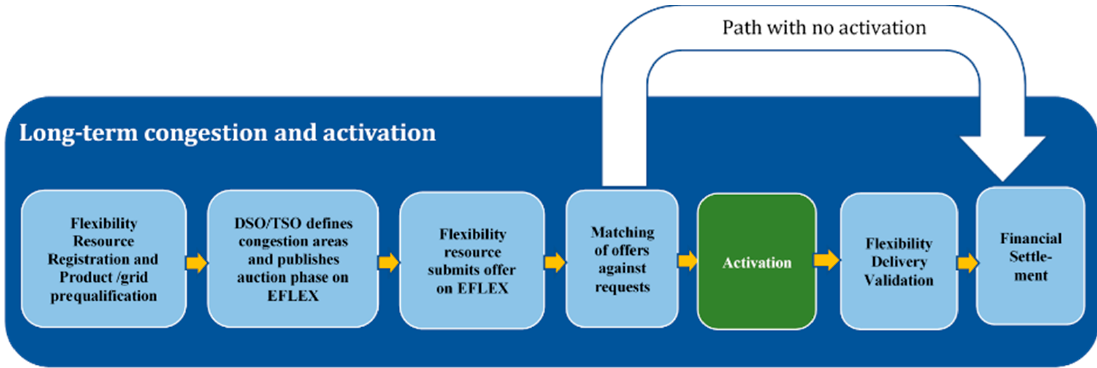
Figure 8. Process diagram summary for business use cases.